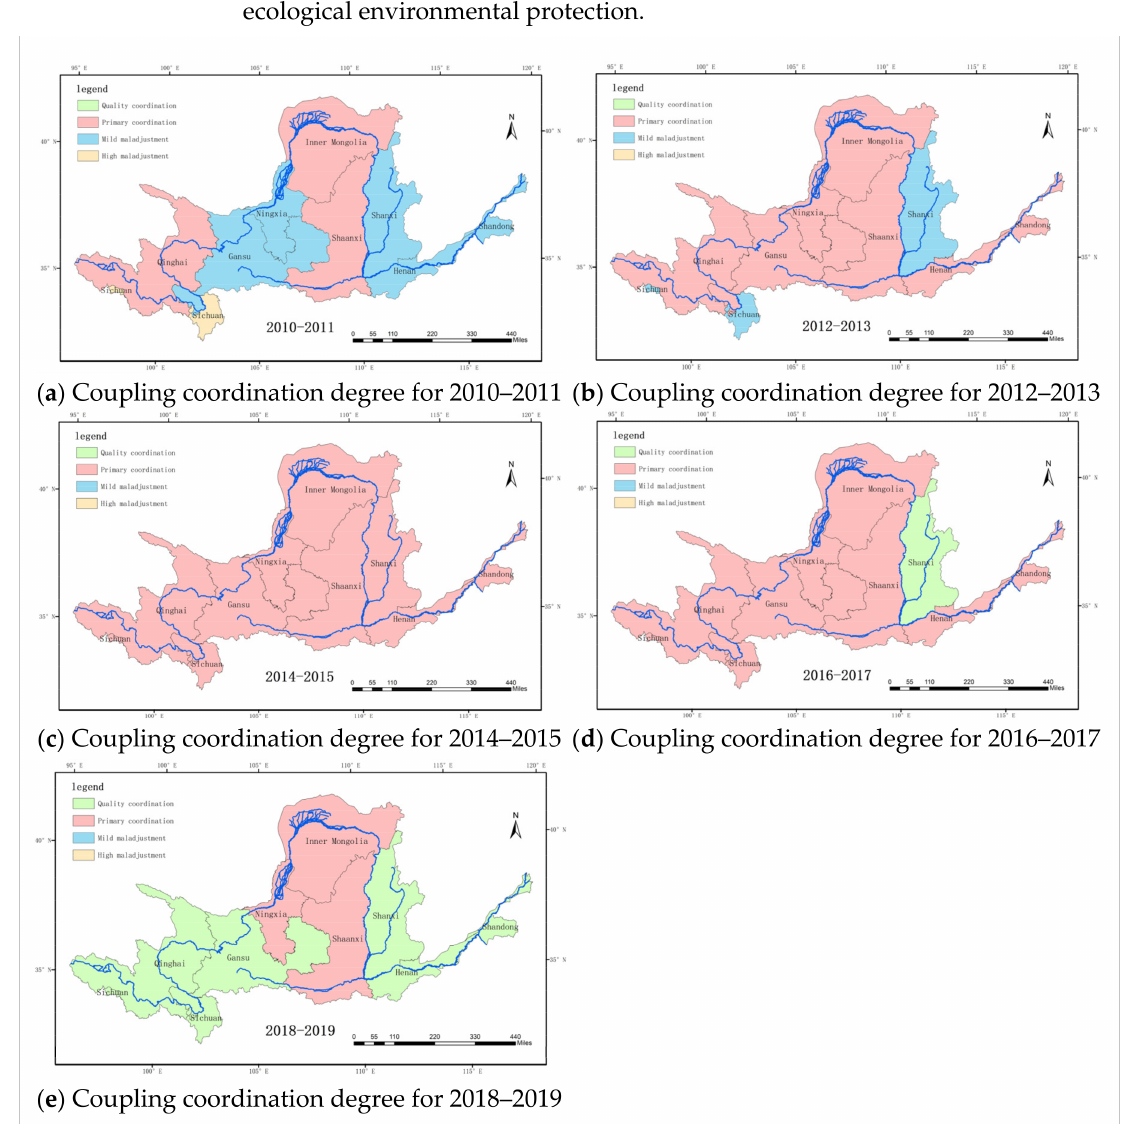
Figure 9. Spatial distribution of the coupling coordination degree in the Yellow River